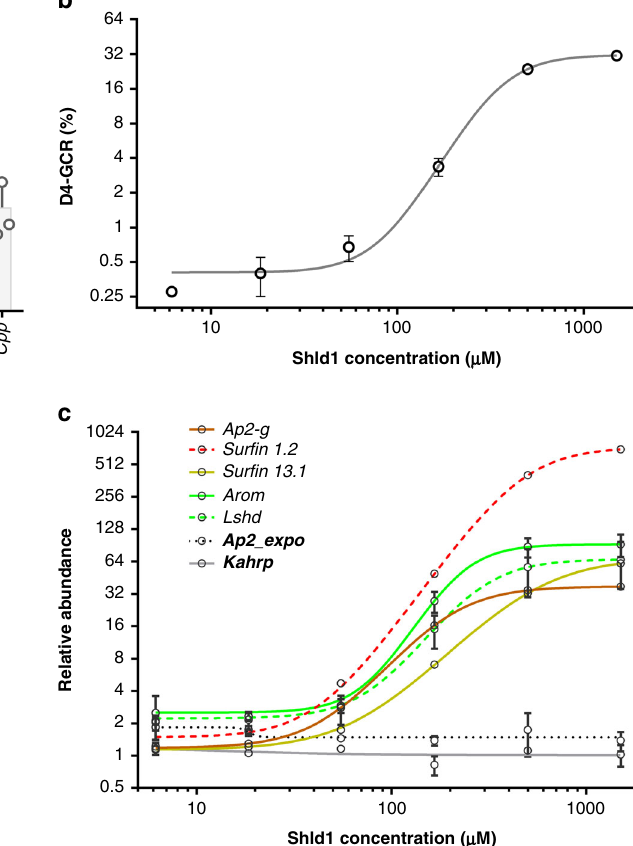
Fig. 2 AP2-G augments expression of H-GCR-associated genes. a Transcript levels of the 18 genes upregulated in the high (H)- gametocyte-conversion rate (GCR) cohort were assayed in RNA from E5.ap2-g.dd parasites harvested (10 – 15 h) after one asexual cycle in the presence or absence of Shield 1 (Shld1). Sbp1 RNA levels, which are high in both asexually and sexually committed ring stages, were used as the endogenous control, and E5 . ap2-g.dd ring- stage parasites grown without Shld1 ( − ) were used as the reference line. The mean and standard error of the mean (SEM) for n = 3 biologically independent experiments are shown. b , c Shld1 dose-response curve of the day (D)4 GCR and gene expression. Ring-stage parasites were exposed to a range of Shld1 concentrations (0, 6.16 nM, 18.5 nM, 55 nM, 166 nM, 500 nM, and 1500 nM), and 10 – 15 h post invasion (hpi) after one asexual cycle an aliquot was isolated for RNA ( c ) and N-acetyl glucosamine was added to the remaining culture to block further asexual replication ( b ). The stage II – III gametocytemia on D4 was used to calculate the D4 GCR ( b ). c The fold change in gene expression between parasites treated with or without the indicated concentration of Shld1. Kahrp and Ap2_expo indicated in bold were included as asexual controls. The mean and range of n = 2 biologically independent experiments are shown for each Shld1 concentration in b and c . The pro fi les of the rest of the gametocyte-committed-ring genes are shown in Supplementary Fig. 2. Source data are provided as a Source Data fi